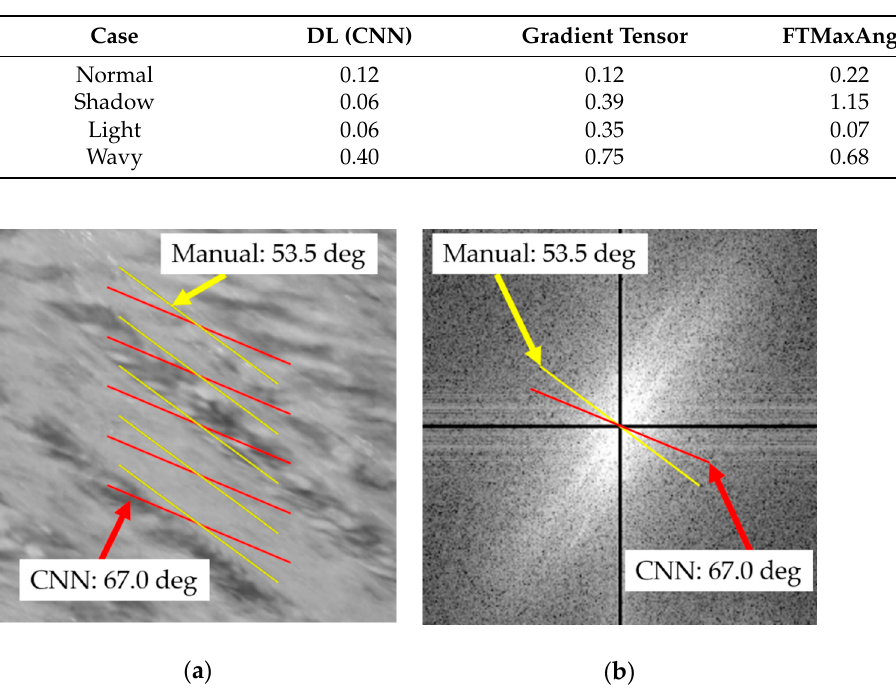
Figure 16. The false detection of peak angle case (red: CNN estimation, yellow: manual estimation): ( a ) original image; ( b ) 2D Fourier transform image.